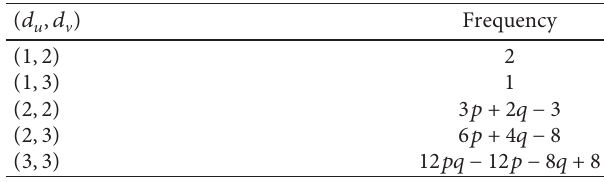
Table 4: Degree-based edge partition of SiC